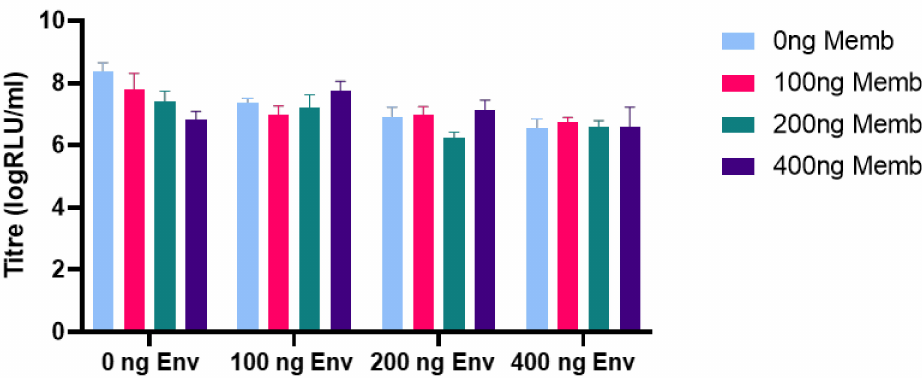
Figure 6. PVs were pseudotyped with the SARS-CoV-2 S protein in addition to combinations of the Envelope (Env) and Membrane (Memb) proteins; PVs produced with 100 ng Envelope and 400 ng Membrane in addition to 50 ng spike had the second highest titres relative to spike